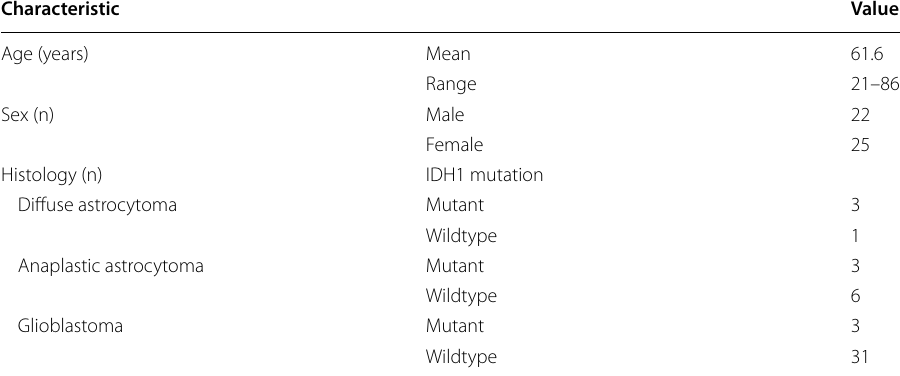
Table 1 Patient clinical characteristics